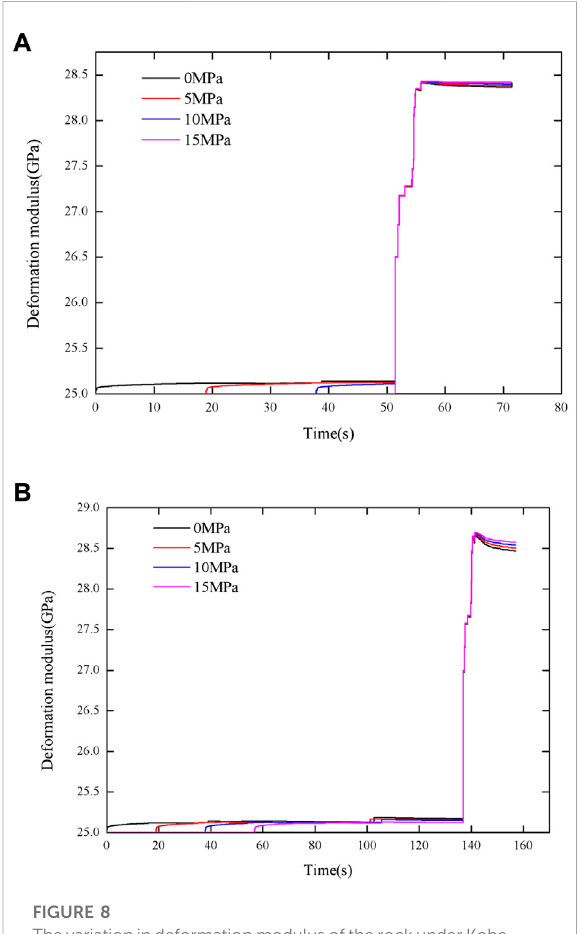
FIGURE 8 Thevariation indeformationmodulus oftherockunderKobe seismic load with different con fi ning pressures: (A) Maximum stress of 30 MPa; (B) Maximum stress of 80 MPa.